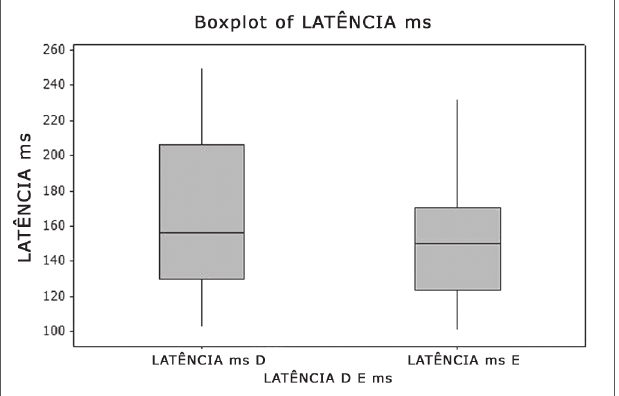
Figura 4. Boxplot - Amplitude Lados Direito e Esquerdo - mcV - micro- Volts D - Direito (N=30 orelhas) E - Esquerdo (N=29